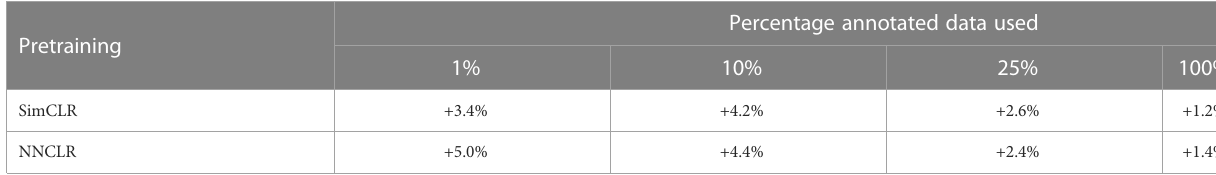
TABLE 1 Relative performance by the accuracy of SimCLR-pretrained and NNCLR-pretrained models as compared to ImageNet preloaded model.